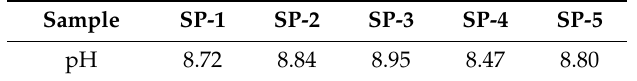
Table 4. Moderately alkaline and strongly alkaline pH of the saponite pulp (SP).